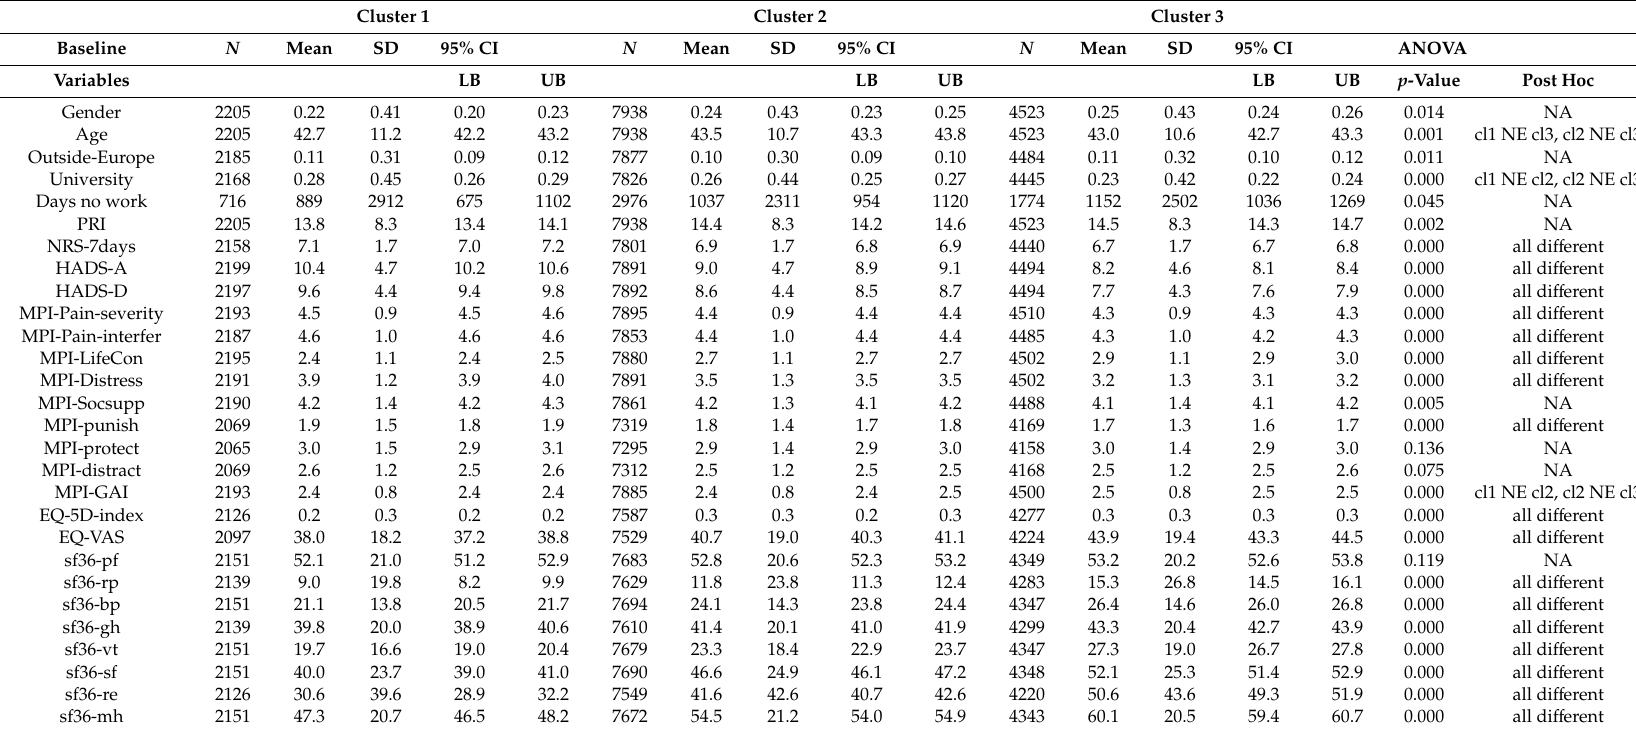
Table 8. Pre-IMMRP values for the three clusters based on MIS obtained